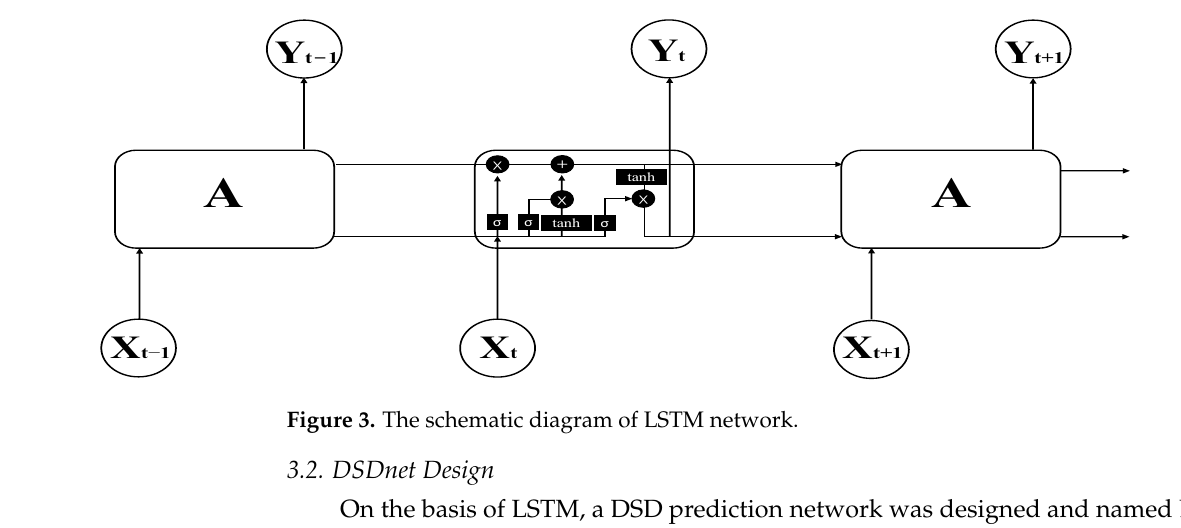
Figure 3. The schematic diagram of LSTM network.